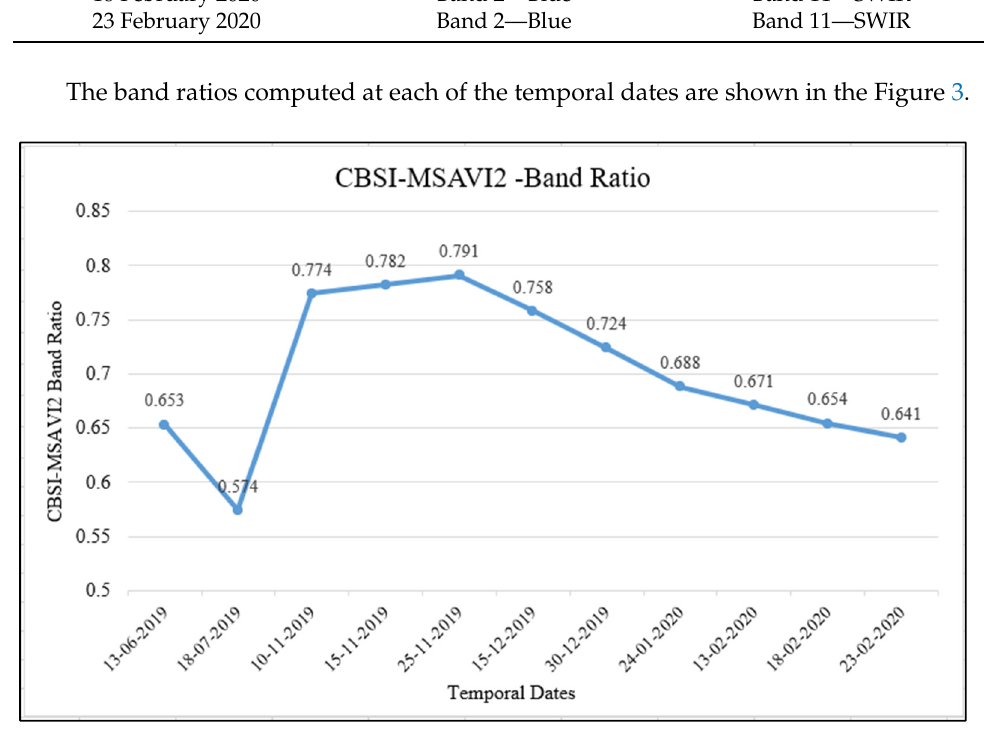
Table 4. Separability analysis using CBSI-MSAVI2 temporal indices images for the selection of best temporal dates to map Pigeon Pea crop with spectrally least similar cotton crop.